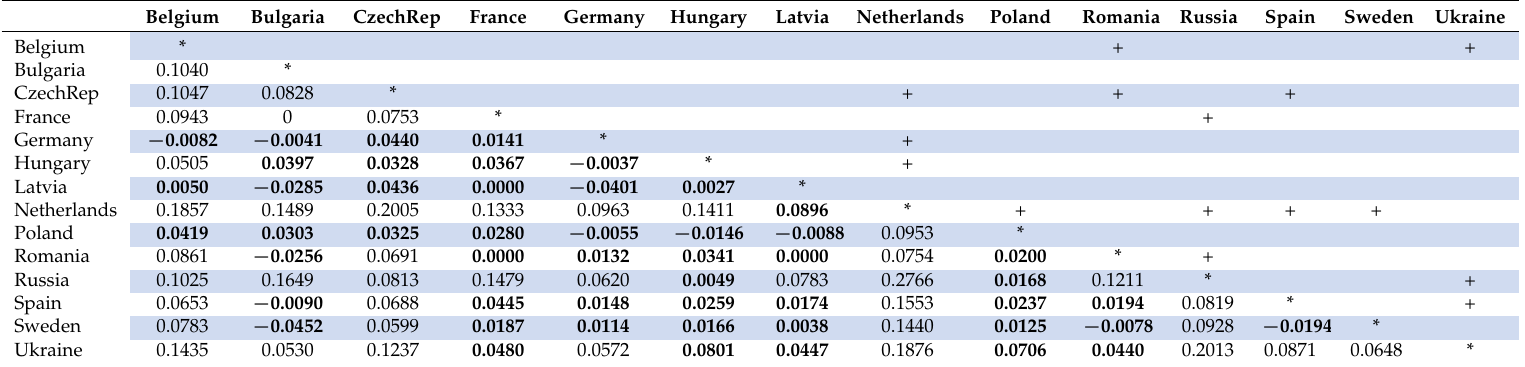
Table 2. Population pairwise F ST indicators. Values which indicate low genetic differentiation (<0.05) are typed in bold. The rest of the values indicate moderate genetic differentiation (0.05 to 0.25). Units with significant p-values (<0.05) are marked with “+” above the